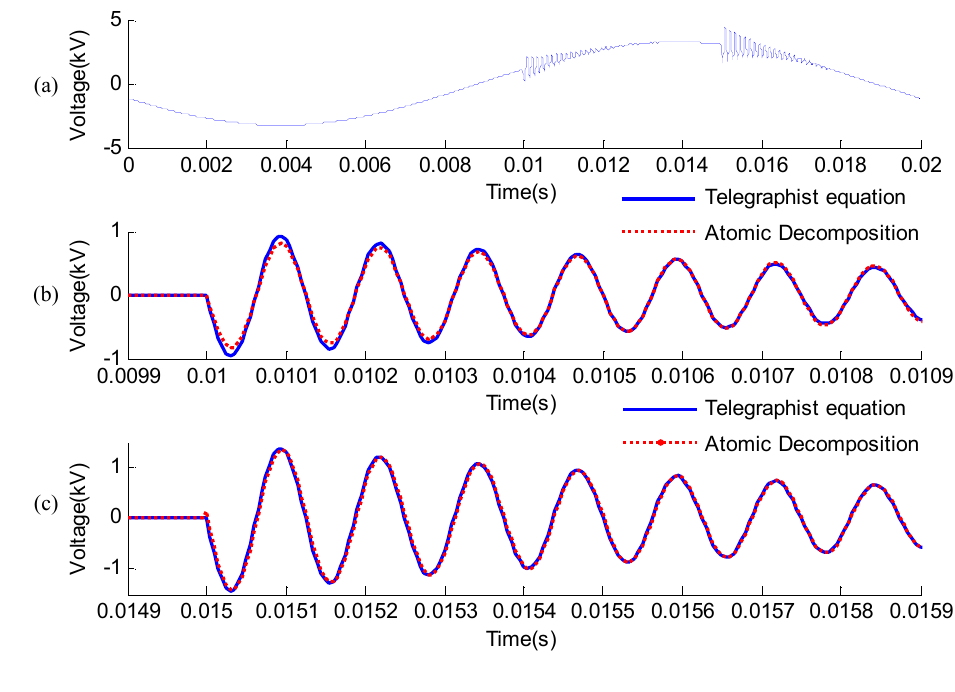
Figure 12. The contrast between the Telegraphist equation and Atomic Decomposition. ( a ) The waveform of a high frequency oscillation and its reflection; ( b ) The contrast between Telegraphist equation and Atomic Decomposition of original high frequency oscillation; ( c ) The contrast between Telegraphist equation and Atomic Decomposition of the reflection of high frequency